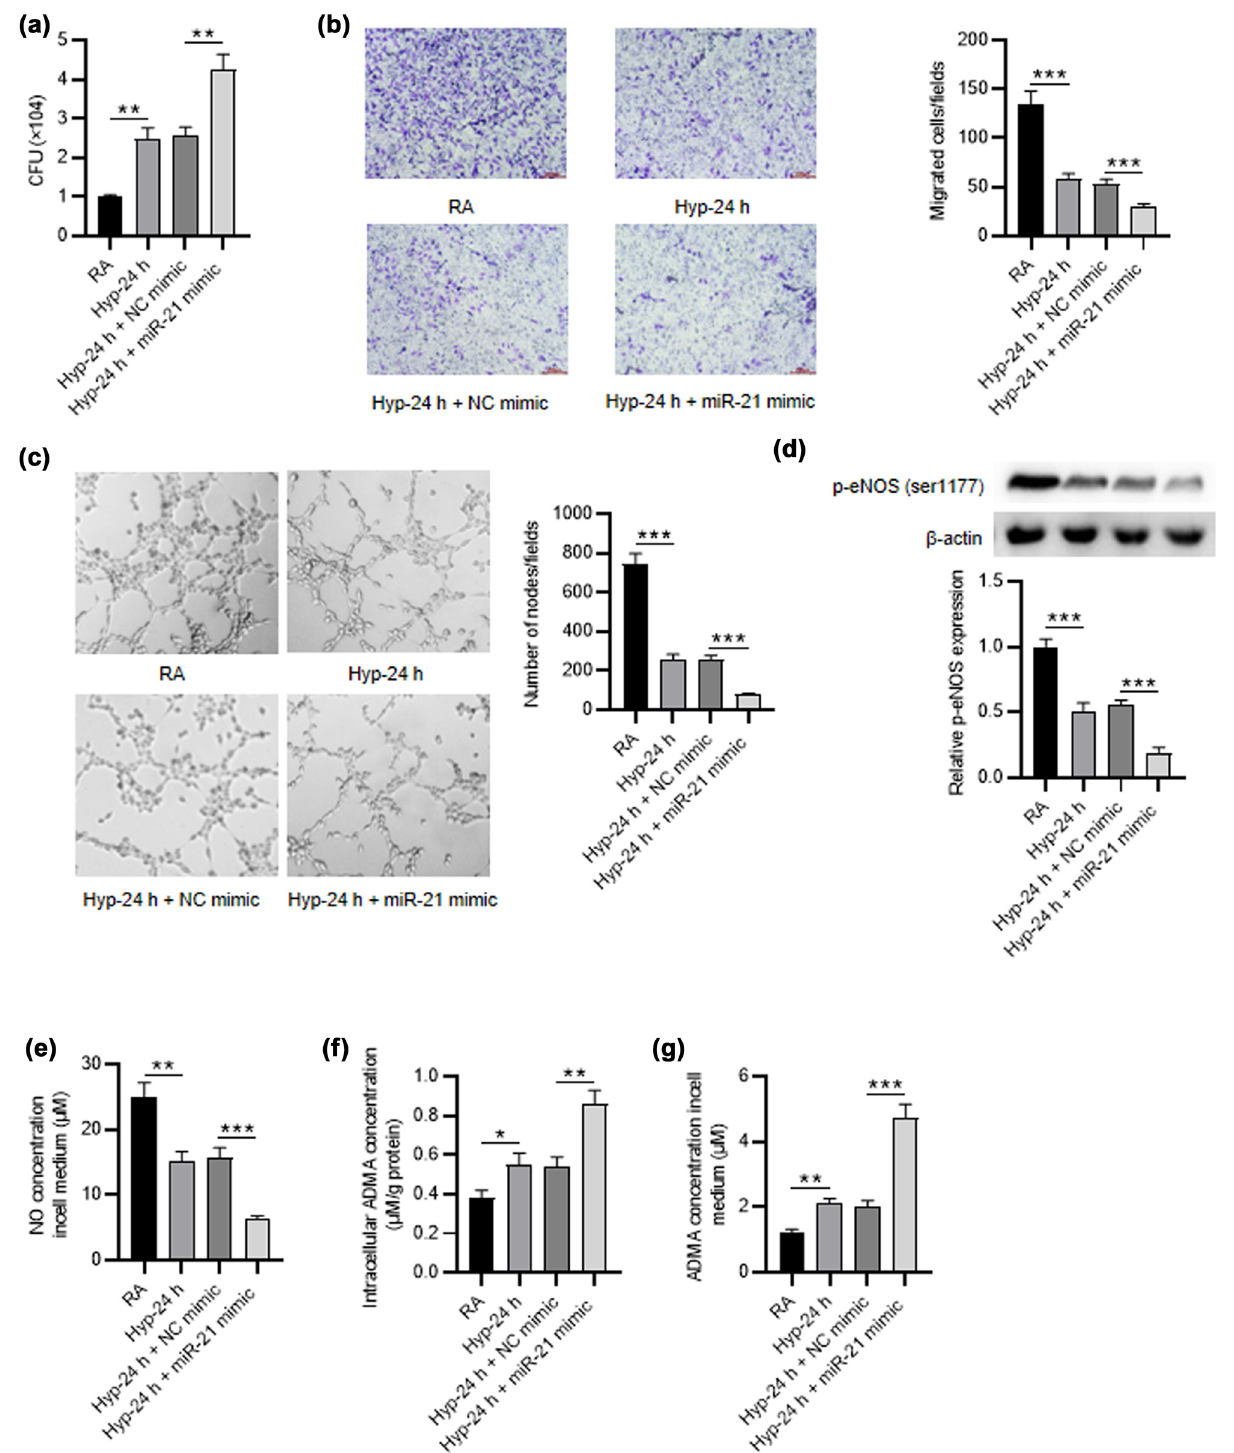
Figure 3: Overexpression of miR - 21 strengthens the e ff ects of hyperoxia in PMVECs. ( a ) The overexpression e ffi ciency of miR - 21 mimic in PMVECs treated with 24 h of hyperoxia was detected by RT - qPCR. ( b ) Transwell assay was applied to detect the migration of hyperoxia - induced PMVECs after miR - 21 overexpression. ( c ) Tube formation assay was performed to estimate the angiogenic activity of hyperoxia - induced PMVECs after miR - 21 overexpression. ( d ) Western blot was utilized to test the p - eNOS ( ser1177 ) level in PMVECs of di ff erent groups ( RA group, hyperoxia - 24 h group, hyperoxia - 24 h + NC mimic group, hyperoxia - 24 h + miR - 21 mimic group ) . ( e – g ) ELISA was utilized to detect the NO production and the intracellular and extracellular ADMA concentration in PMVECs of di ff erent groups. Quanti fi ed values are mean values ± standard deviation of at least three independent experiments. ** p < 0.01, *** p <